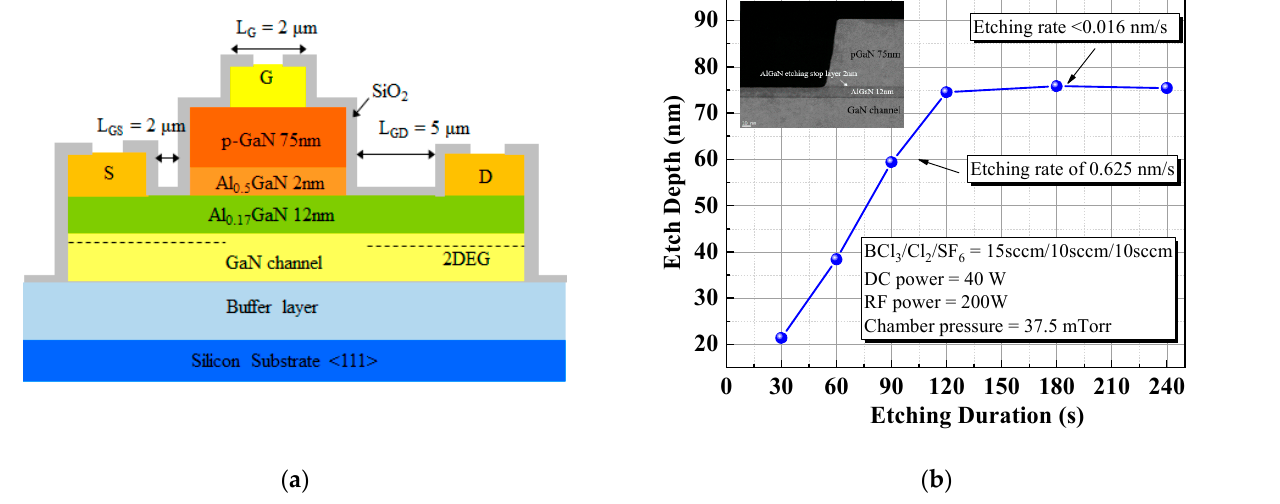
Figure 1. ( a ) Schematic cross-sectional structure of the p-GaN gate HEMT with an Al 0.5 GaN etch-stop layer design. ( b ) p-GaN etch depth versus the etch duration and TEM image after etching